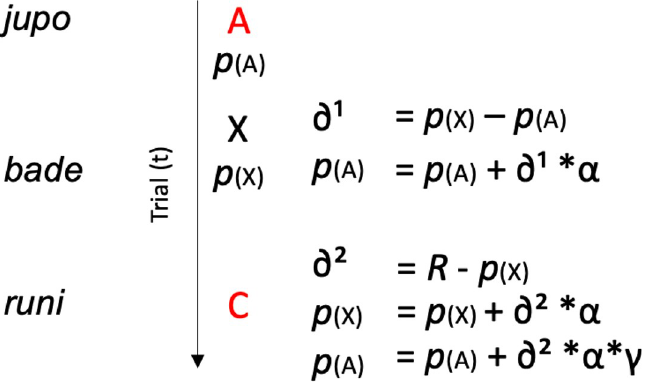
Fig 6. TD model’s computations during a NADs block’s trial. The initial A element of the phrase (e.g., jupo ) carries a prediction value p (A). A prediction error @ 1 , generated when this prediction is not met by the occurrence of the second word X ( bade ), is used to update the initial prediction p (A), scaled by the learning rate α . A new prediction is issued from this second word p (X), which also generates a prediction error @ 2 on C ( runi ). @ 2 is then used to update both p (X) and p (A), scaled by the learning rate and (down)scaled by the temporal discounting factor γ in the case of the more distant prediction p (A). NAD, nonadjacent dependency; TD, temporal difference.